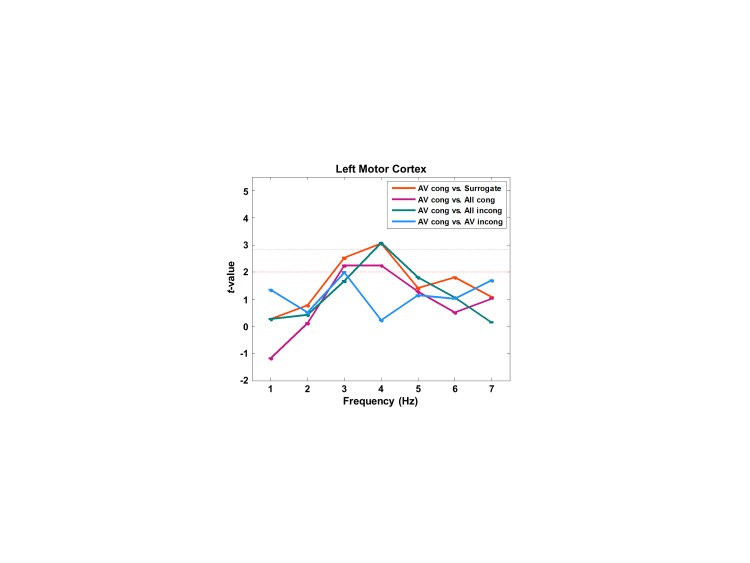
Partial coherence between lip movements and left motor cortex.We here show a frequency-specific plot for partial coherence between lip movements and left motor cortex.We extracted the maximum voxel in the left motor cortex (precentral gyrus) from the contrast for attention effect (AV congruent vs. All congruent shown in Figure 3D; MNI coordinates = [-44 -16 56]). This confirmed lip movements entrain left motor cortex at 4 Hz irrespective of auditory speech signals.